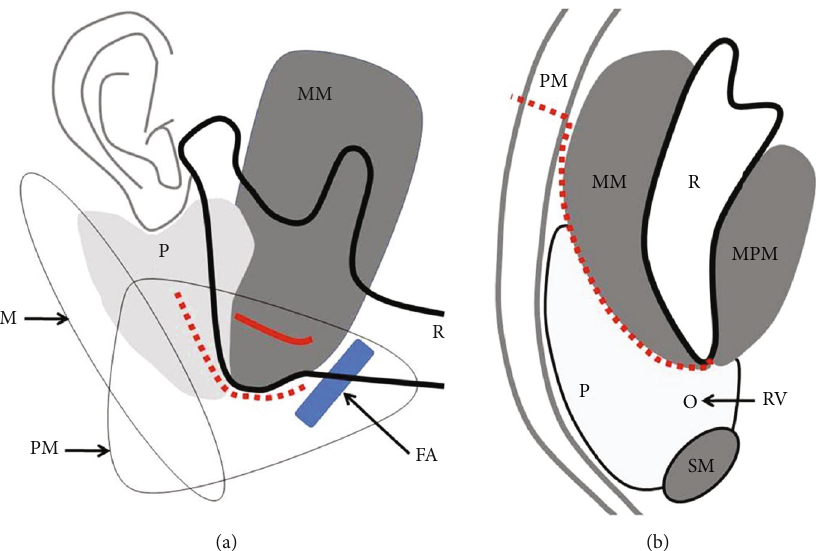
Figure 5: (a) FA: facial artery; MM: masseter muscle; P: parotid glands; PM: platysma; R: mandibular bone; SM: sternocleidomastoid muscle; red dotted line: skin incision line; red line: platysma incision line. (b) MM: masseter muscle; P: parotid glands; MPM: medial pterygoid muscle; PM: platysma; R: mandibular bone; RV: retromandibular-vein; SM: sternocleidomastoid muscle; Red dotted line: the approach